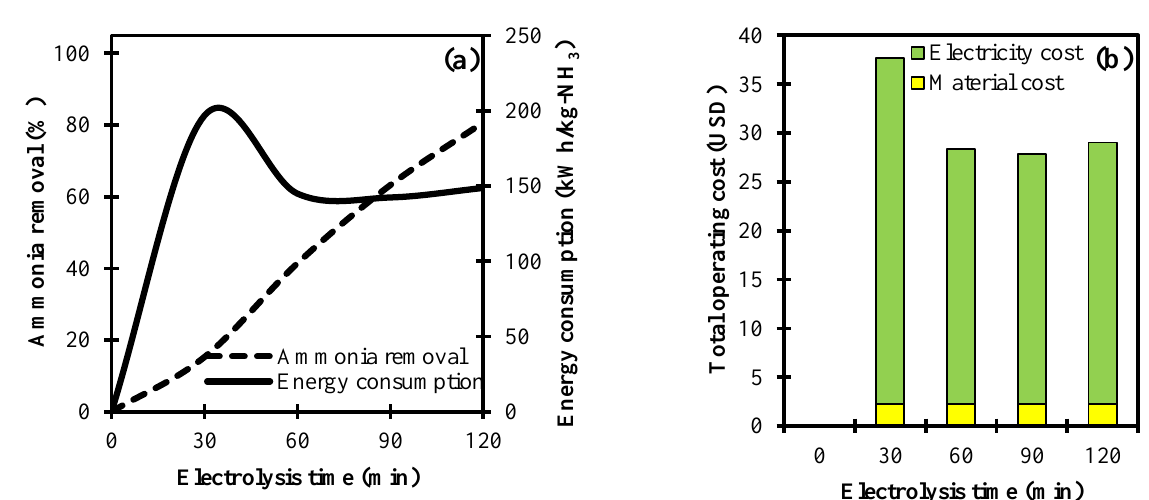
Figure 5. Process variable analyses of electrolysis time towards: ( a ) Ammonia removal, energy consumption, and ( b ) total operating cost in an electrochemical system.